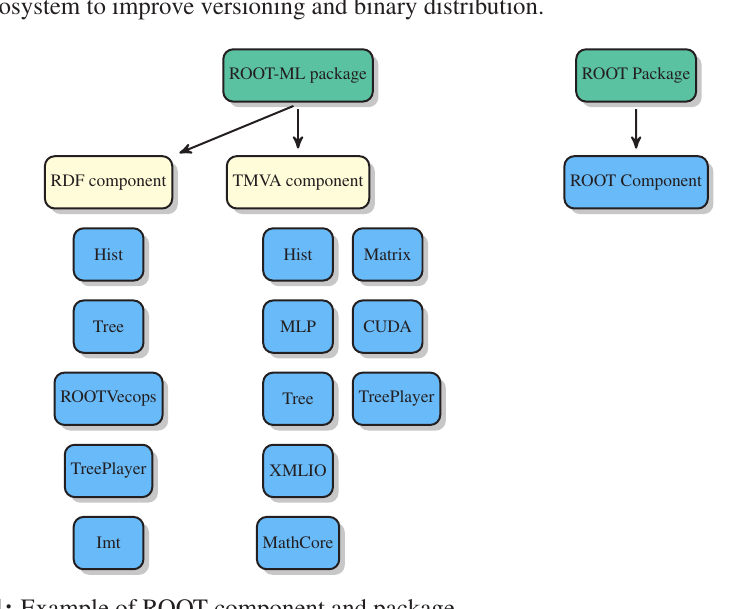
Figure 1: Example of ROOT component and